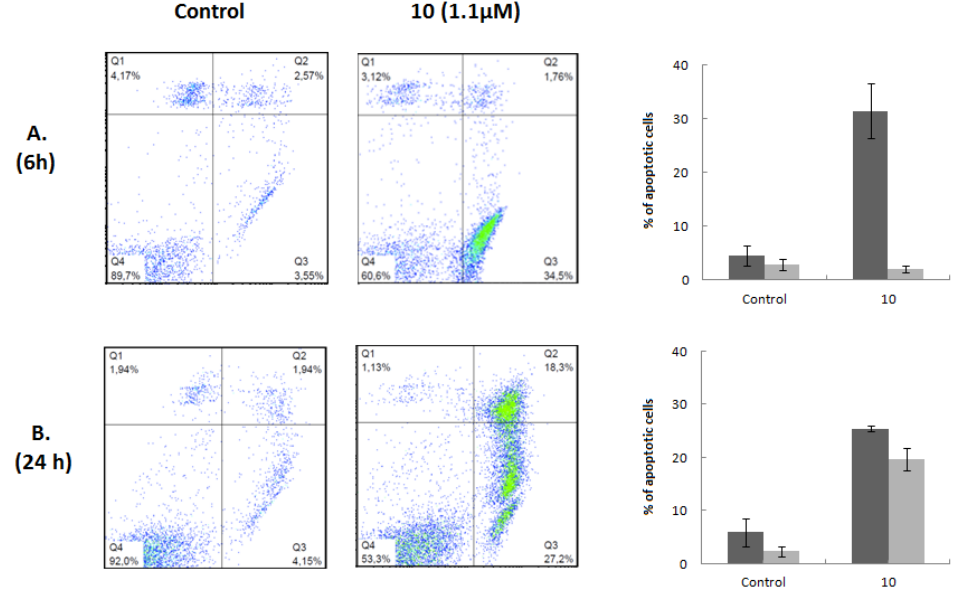
Figure 4. Induction of apoptosis by compound 10 . Flow cytometric quantification of apoptosis in Jurkat cells untreated (Control) or treated with 1.1 µ M compound 10 for 6 ( A ) and 24 h ( B ). After treatment, cells were stained with annexin V-FICT/PI and analyzed by flow cytometry. A representative dot plot is shown for each time of incubation and condition; the right quadrants of each diagram (annexin + /PI − and annexin + /PI + ) represent apoptotic cells. The percentage of early (dark gray bar) and late (light gray bar) apoptotic cells in each condition is represented as a bars diagram, calculated from dot plots. Results are presented as means ± SD of three independent experiments.